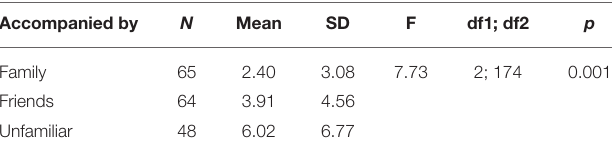
TABLE 5 | Significance of number of reception/asylum center and PTSD development differences on CRIES and SCMQ scales.